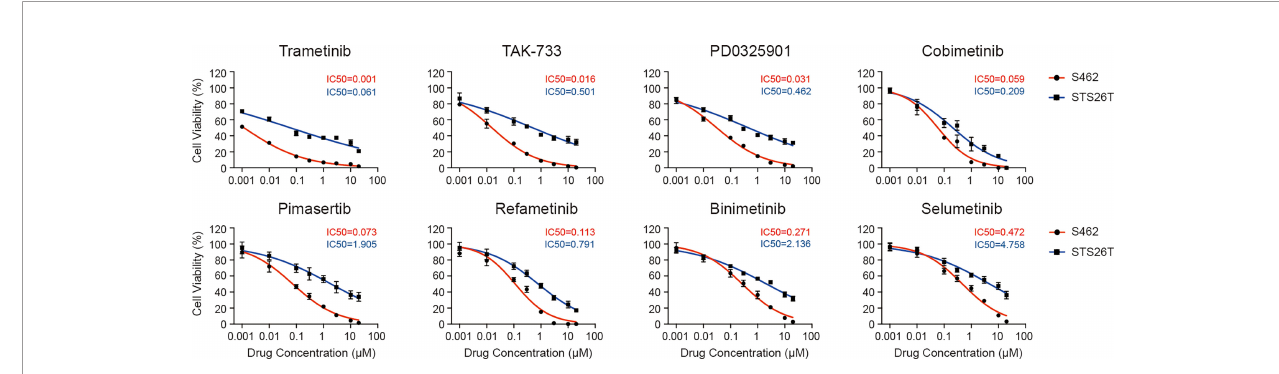
FIGURE 2 | Different ef fi cacy of MEK inhibitors in reducing the viability of MPNST cells. Cell viability of MPNST cell line S462 (the NF1-de fi cient human MPNST cell line) and STS26T (the NF1-wild-type human MPNST cell line with BRAF V600E and PTEN loss) after treated with MEK inhibitors for 96